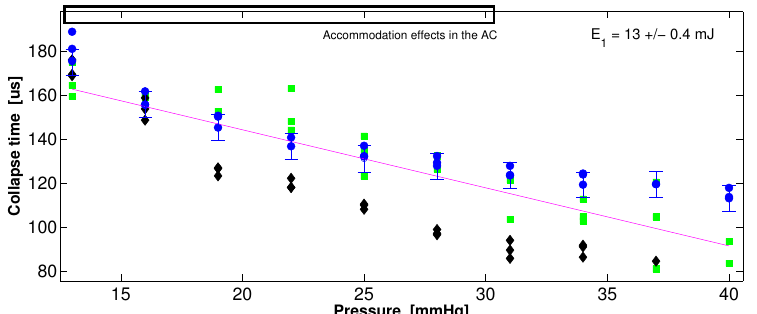
Figure 9. Dispersion of the collapse time data at increasing intraocular pressure (IOP) for three pig eyes: Eye1 (M, circles), Eye2 (S, squares), and Eye3 (M, diamonds). The error bars for the diamonds and squares are the same as those presented in the circles; therefore, to improve the display of the plot, they were omitted. Each data point corresponds to one shot of the pump beam.